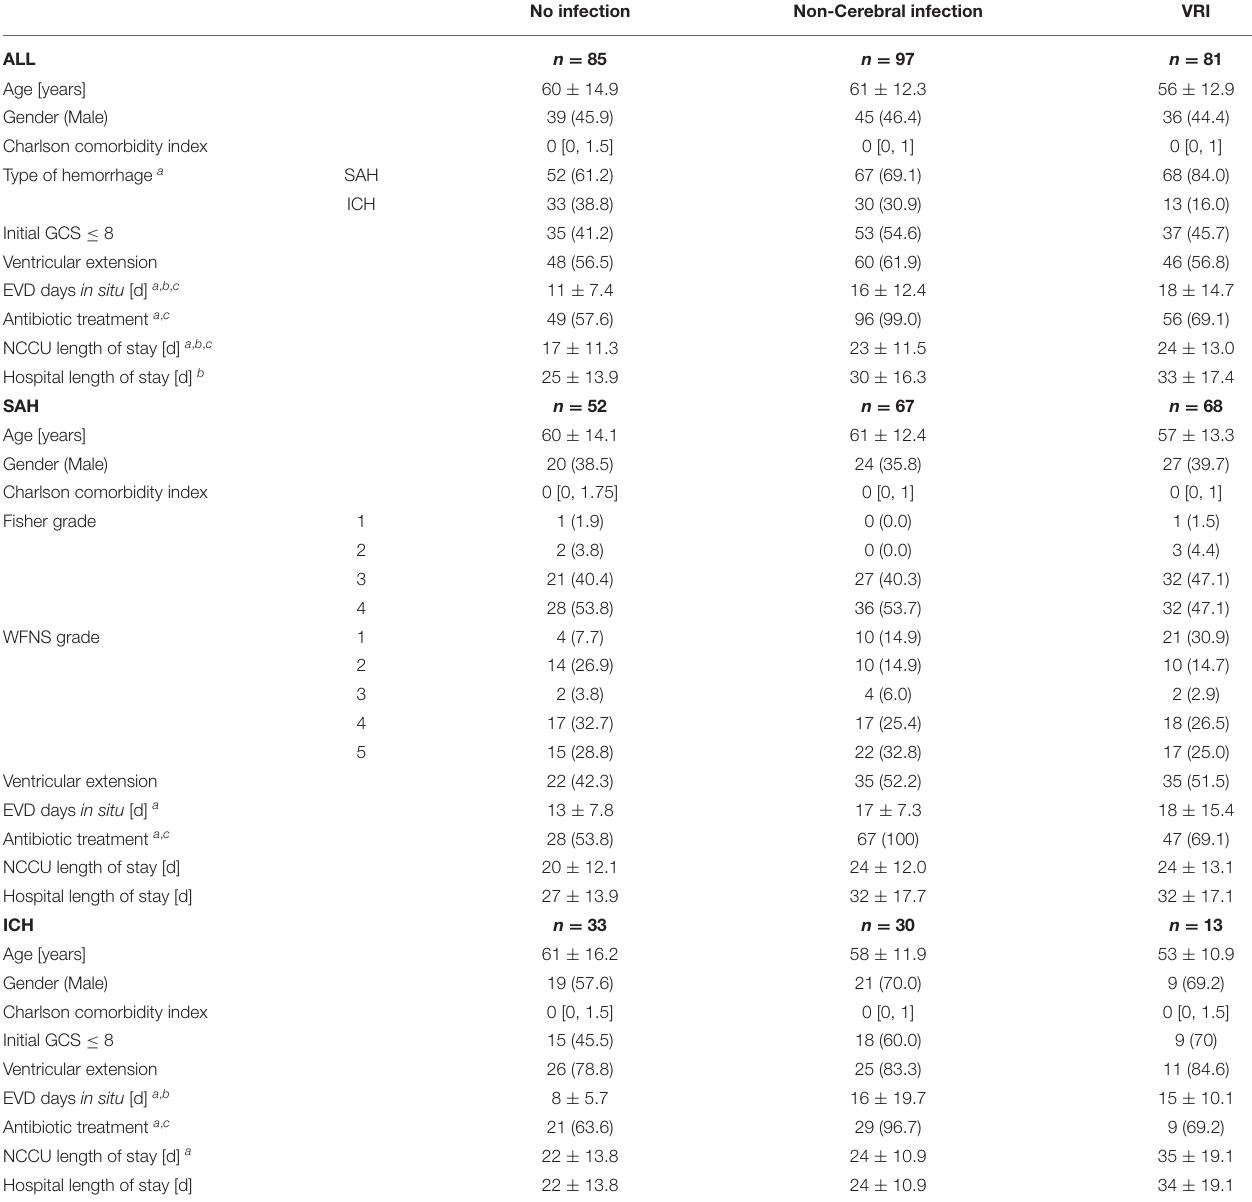
TABLE 1 | Patients’ demographics and